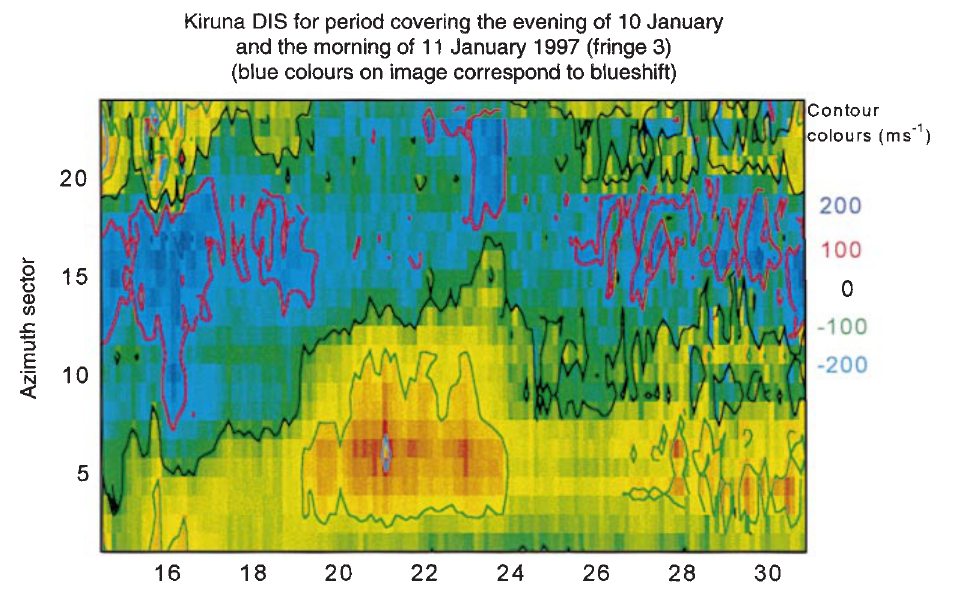
Fig. 5. A summary of the ther- mospheric wind behaviour above Kiruna during the evening of Jan- uary 10 and the early morning of January